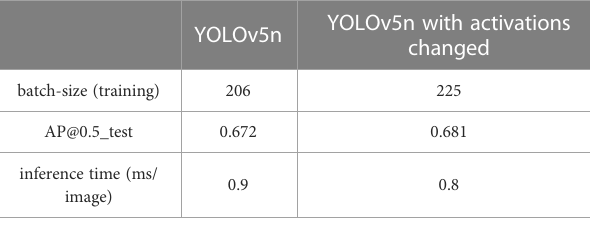
TABLE 2 Plume detection performance comparisons between different scale models of YOLOv5-v6.1.